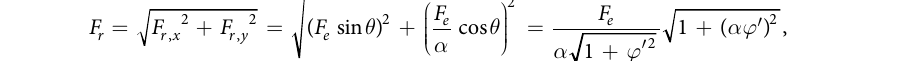
C ( ) 2 ϕ ∈ while symmetricity is